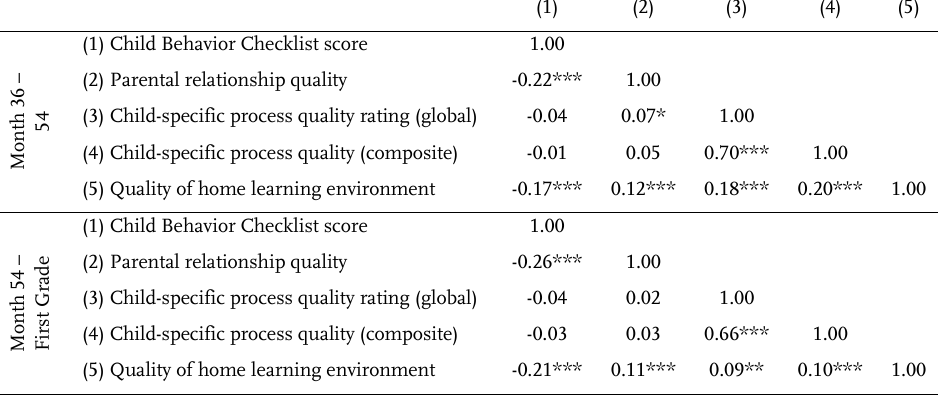
Table 2 : Bivariate correlations of main